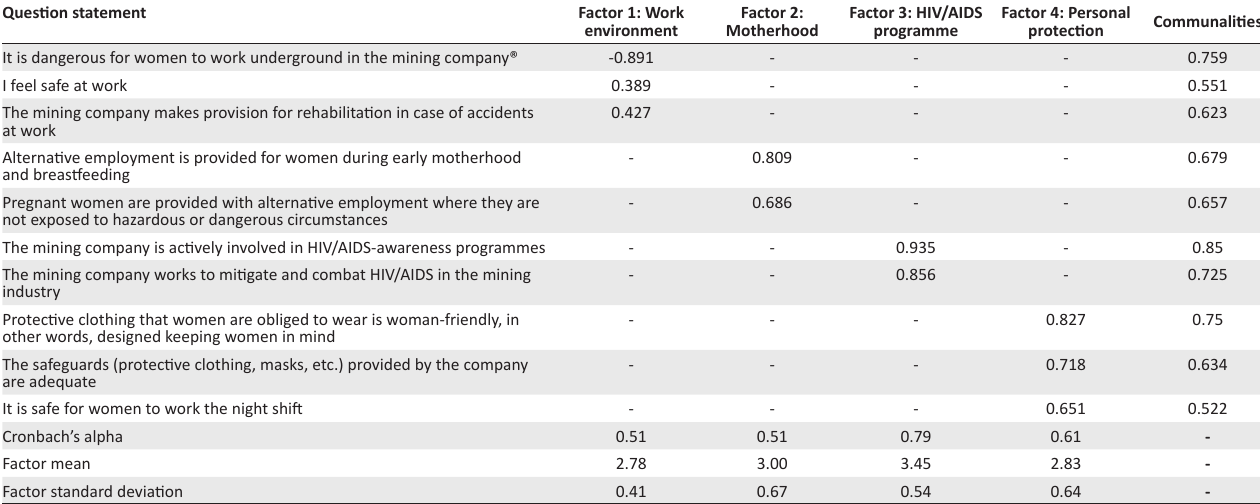
TABLE 5: Pattern matrix † of health and safety in the workplace.